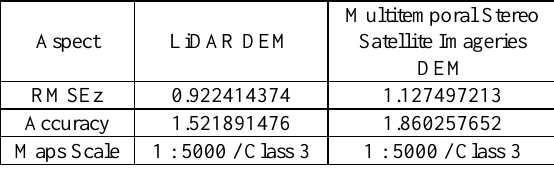
Table 5. Vertical accuracy comparison between Multitemporal Stereo Satellite Imageries and LiDAR